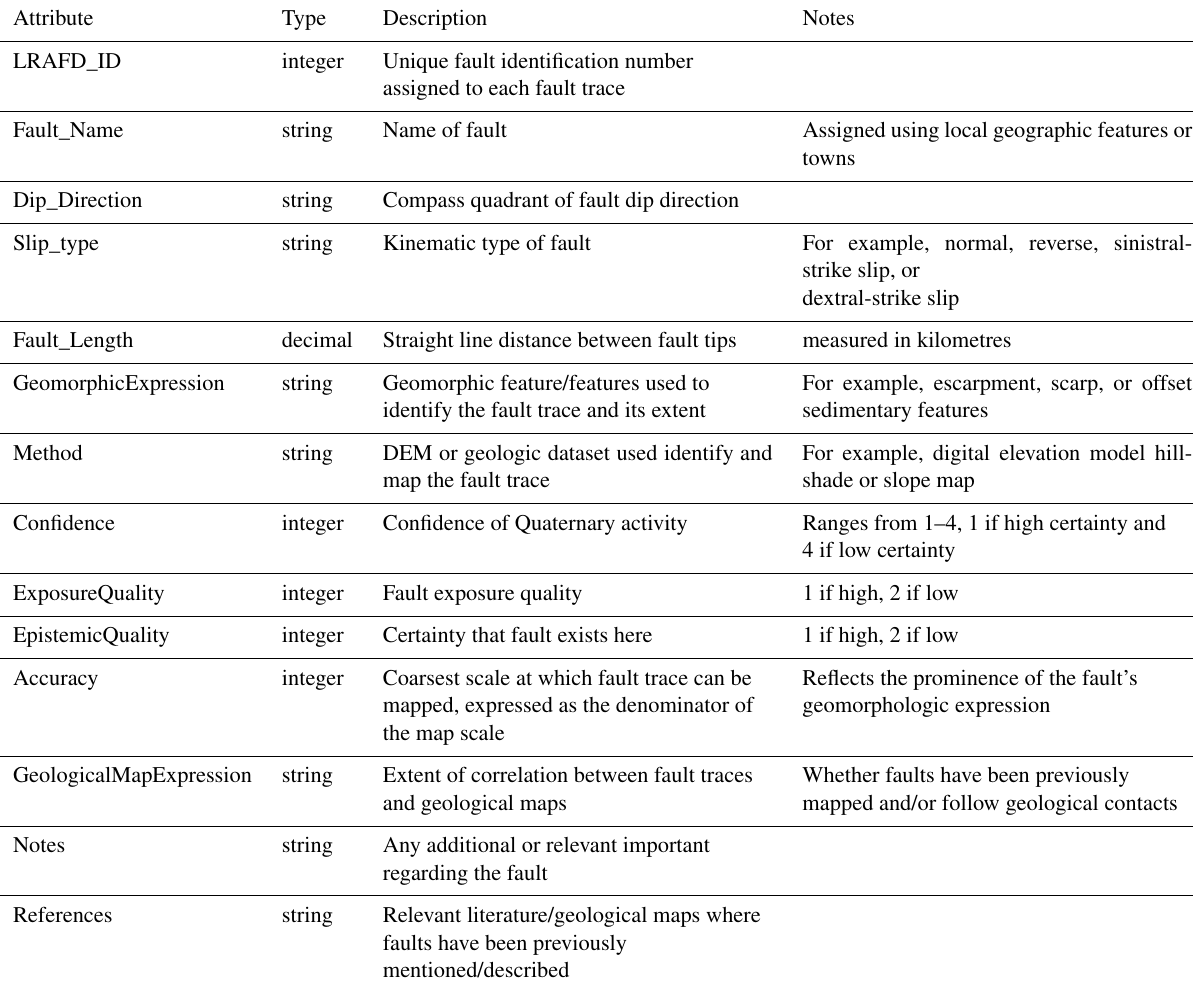
Table 1. The Luangwa Rift Active Fault Database attributes. The attributes are adapted from the Global Earthquake Model Global Active Faults Database (Styron and Pagani,